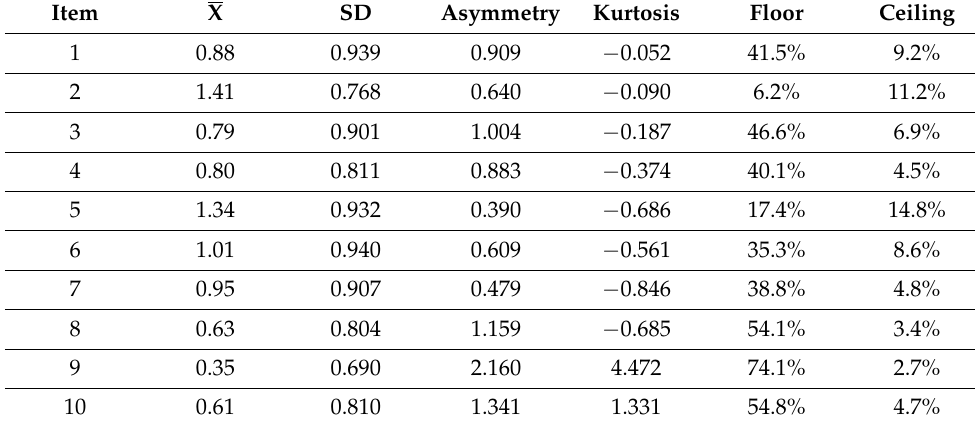
Table 2. Descriptive analysis of each item, as well as floor and ceiling